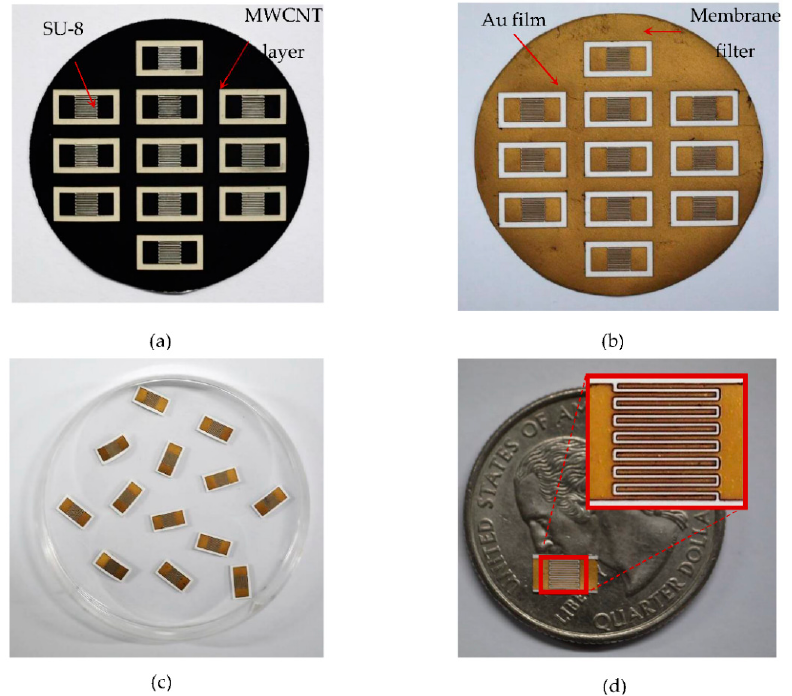
Figure 4. ( a ) The deposited MWCNT film (buckypaper) on the membrane substrate with SU-8 frame after vacuum filtration; ( b ) The micro-SC after depositing the Au layer and removing the SU-8 frame; ( c , d ) Fabricated micro-SCs before packaging.